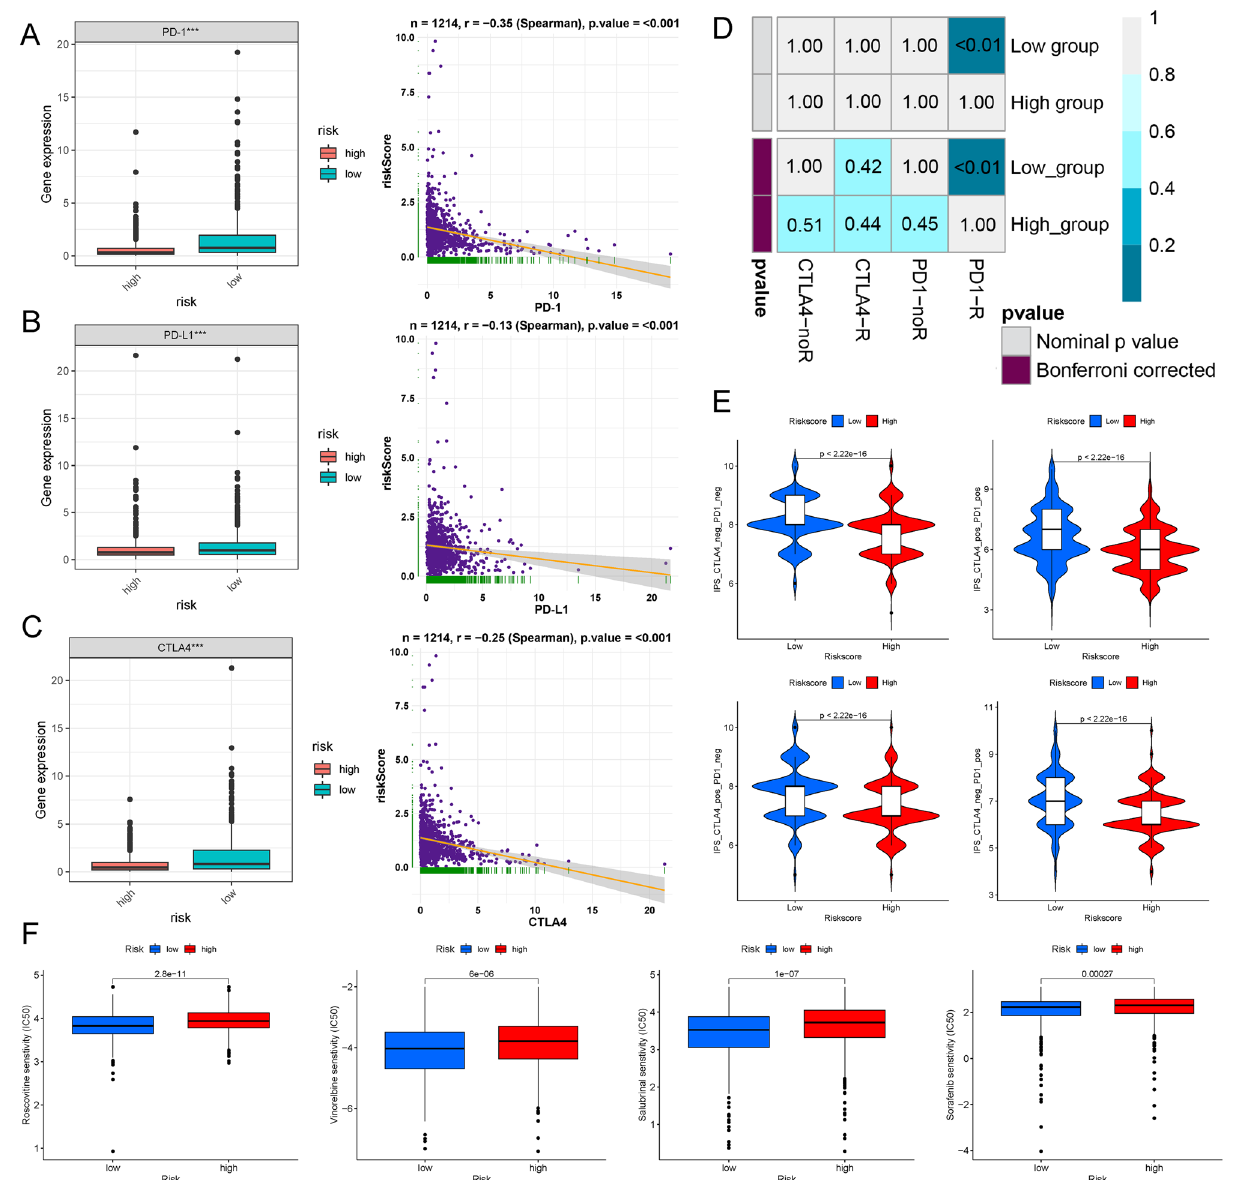
Figure 10. The response to immune checkpoint inhibitors. ( A – C ) Relative expression and correlation analysis of three immune checkpoints (PD-1, PD-L1, and CTLA-4) between high- and low-risk groups of breast cancer (BC) patients. ( D ) The response to anti-PD-1 and anti-CTLA-4 immunotherapy in the high- and low-risk groups was evaluated via the submap algorithm. ( E ) The immunophenoscore (IPS) was used to predict patient response to immune checkpoint inhibitors. ( F ) The 7 immune-related genes (IRGs) in our risk model were significantly correlated with the most common chemotherapeutic drugs. BC breast cancer, IPS immunophenoscore, IRG immune-related